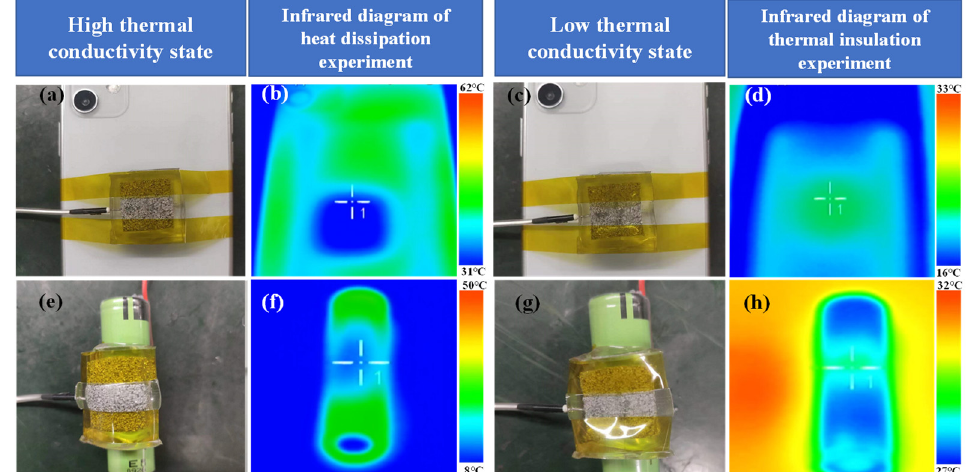
Figure 5. ( a , b ) physical and infrared images of high thermal conductivity B-LM-ECF on smartphone for thermal insulation. ( c , d ) physical and infrared images of low thermal conductivity B-LM-ECF on smartphone for thermal insulation. ( e , f ) physical and infrared images of high thermal conductivity B-LM-ECF on lithium battery for thermal insulation. ( g , h ) physical and infrared images of low thermal conductivity B-LM-ECF on lithium battery for thermal insulation.